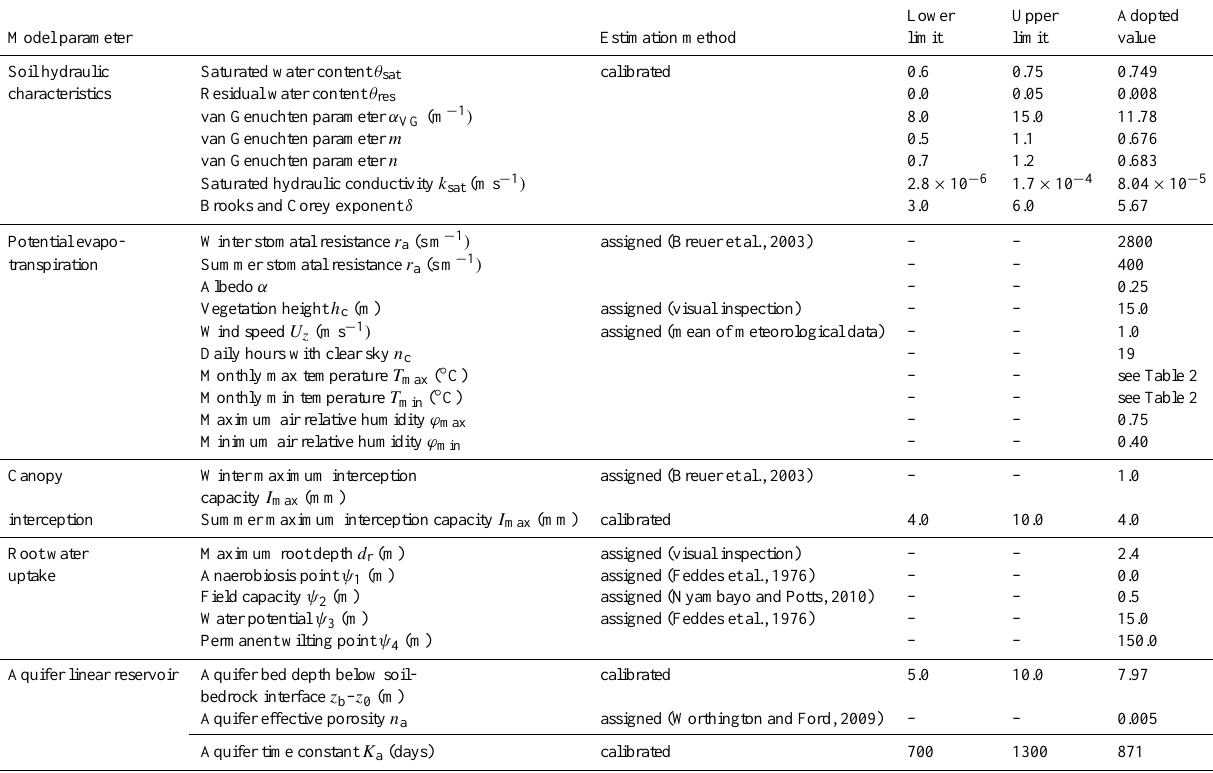
Table 2. Summary of model